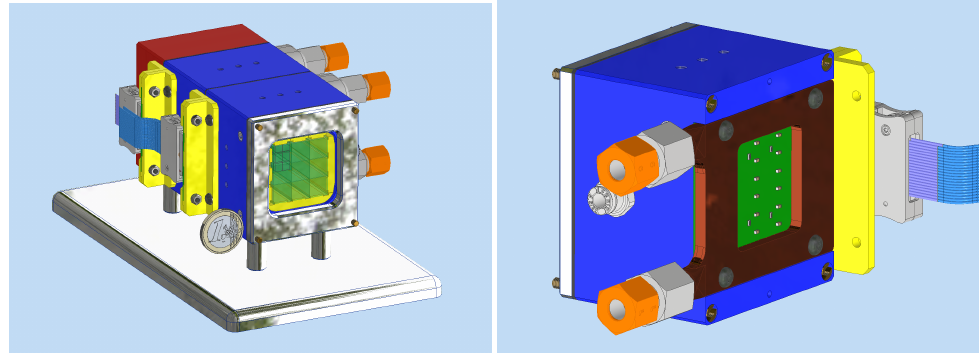
Figure 7. CAD 3D model of Crilin Prototype (Proto-1) on the ( left ). On the ( right ) a single module detail showing the cold plate heat exchanger mounted over the electronic